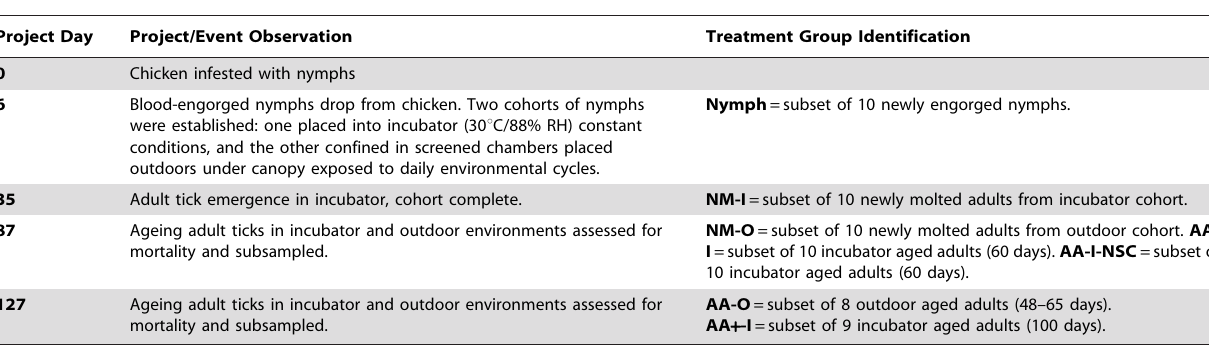
Table 1. Project time-line and identification of experimental treatments to assess the microbiome of the lone star tick, Amblyomma americanum , from nymphal blood feeding, separation of cohorts into environmental conditions, and aging of adult